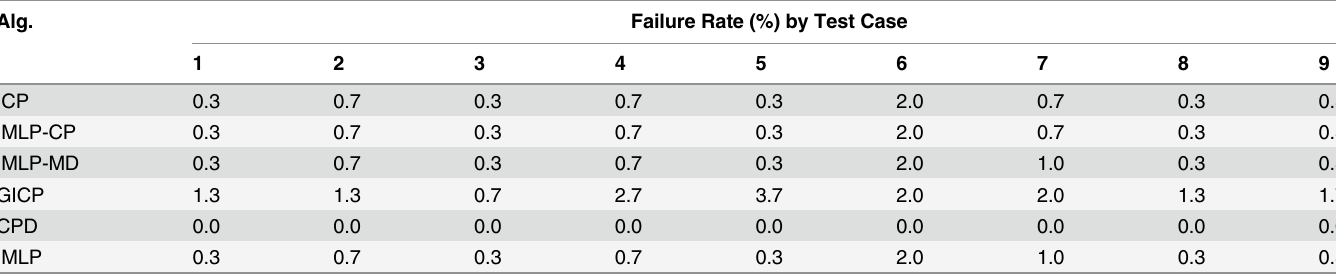
Table 8. Registration failure rates for registering a point-cloud target shape. (Experiment 4B). Alg.